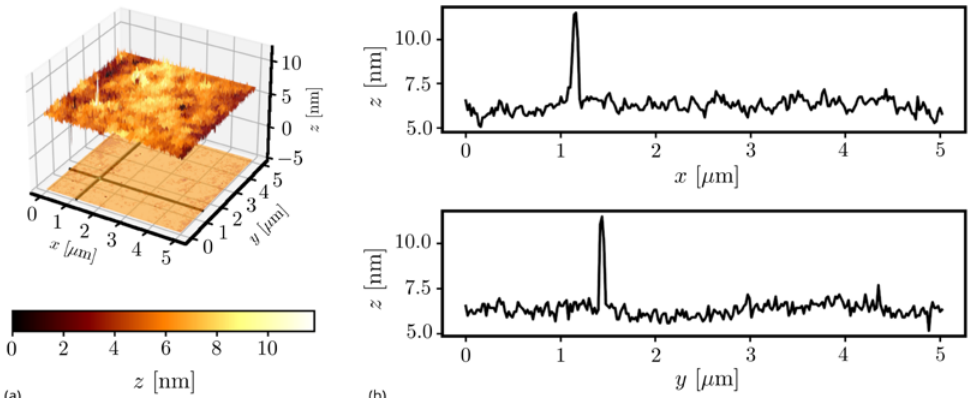
Figure 3. An AFM image ( a ) and roughness profiles ( b ) of the top surface of the SiO 2 :TiO 2 film deposited on a soda–lime glass substrate.